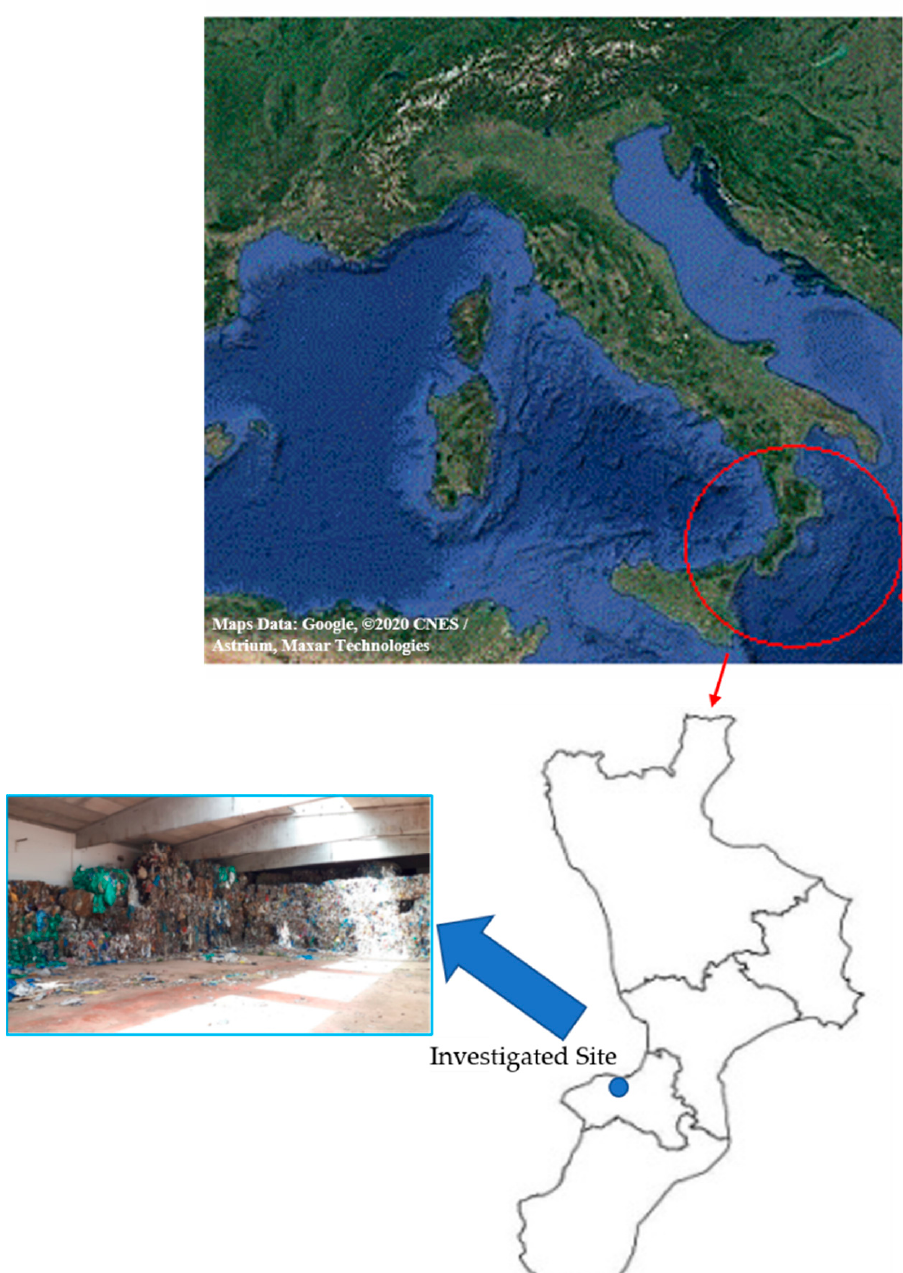
Figure 1. Map of the Calabria region (Italy), with the location of the investigated site (38°42’39.50” N, 16°04’57.01’’ E) indicated. Its geolithological map, reported in Figure 2, highlights how the site of interest is classified with the hydraulic risk level R4, on a 4-level scale [23], in terms of the probability that an adverse potentially destructive phenomenon can occur within a given time and over an